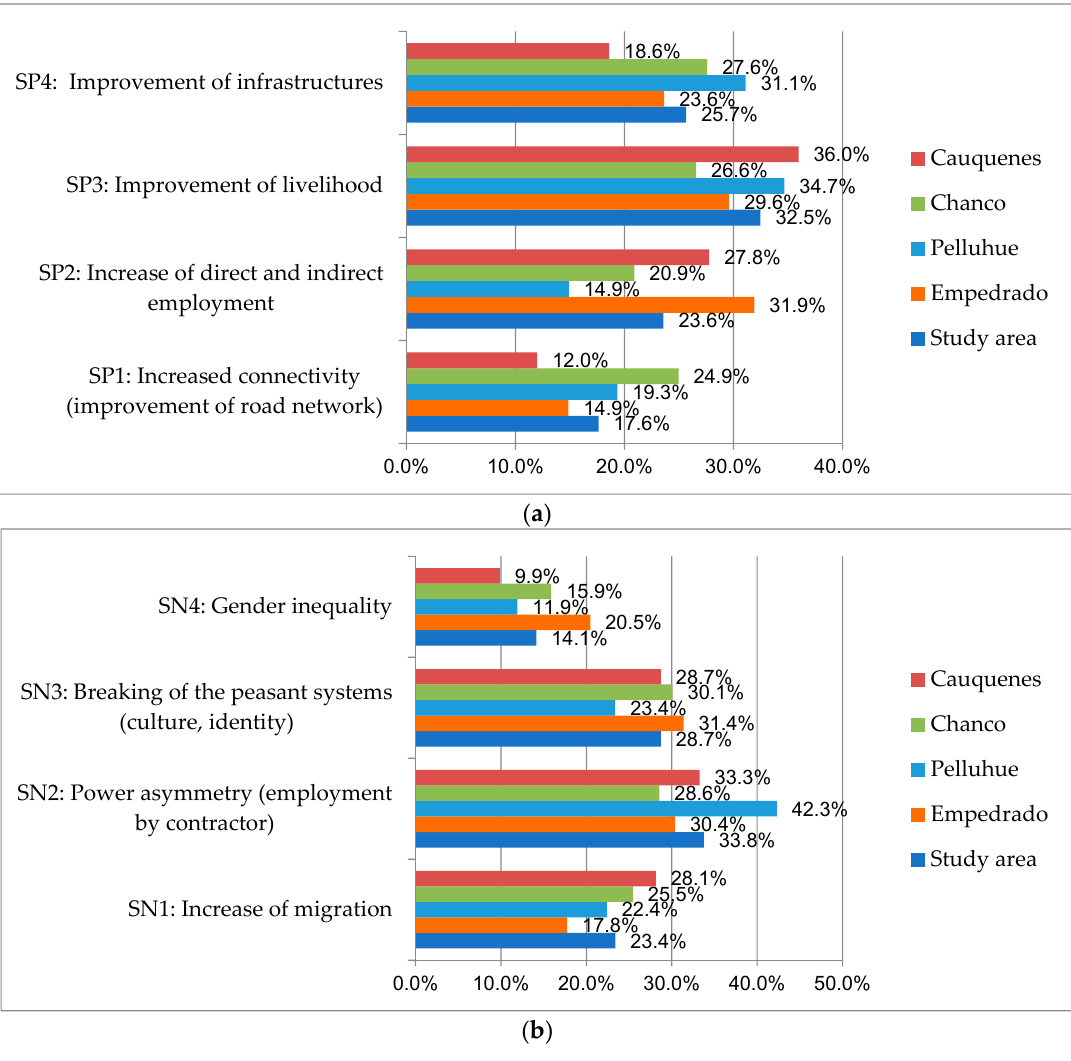
Figure 7. Social externalities: comparison among municipalities ( a ) positive externalities; ( b ) negative externalities.